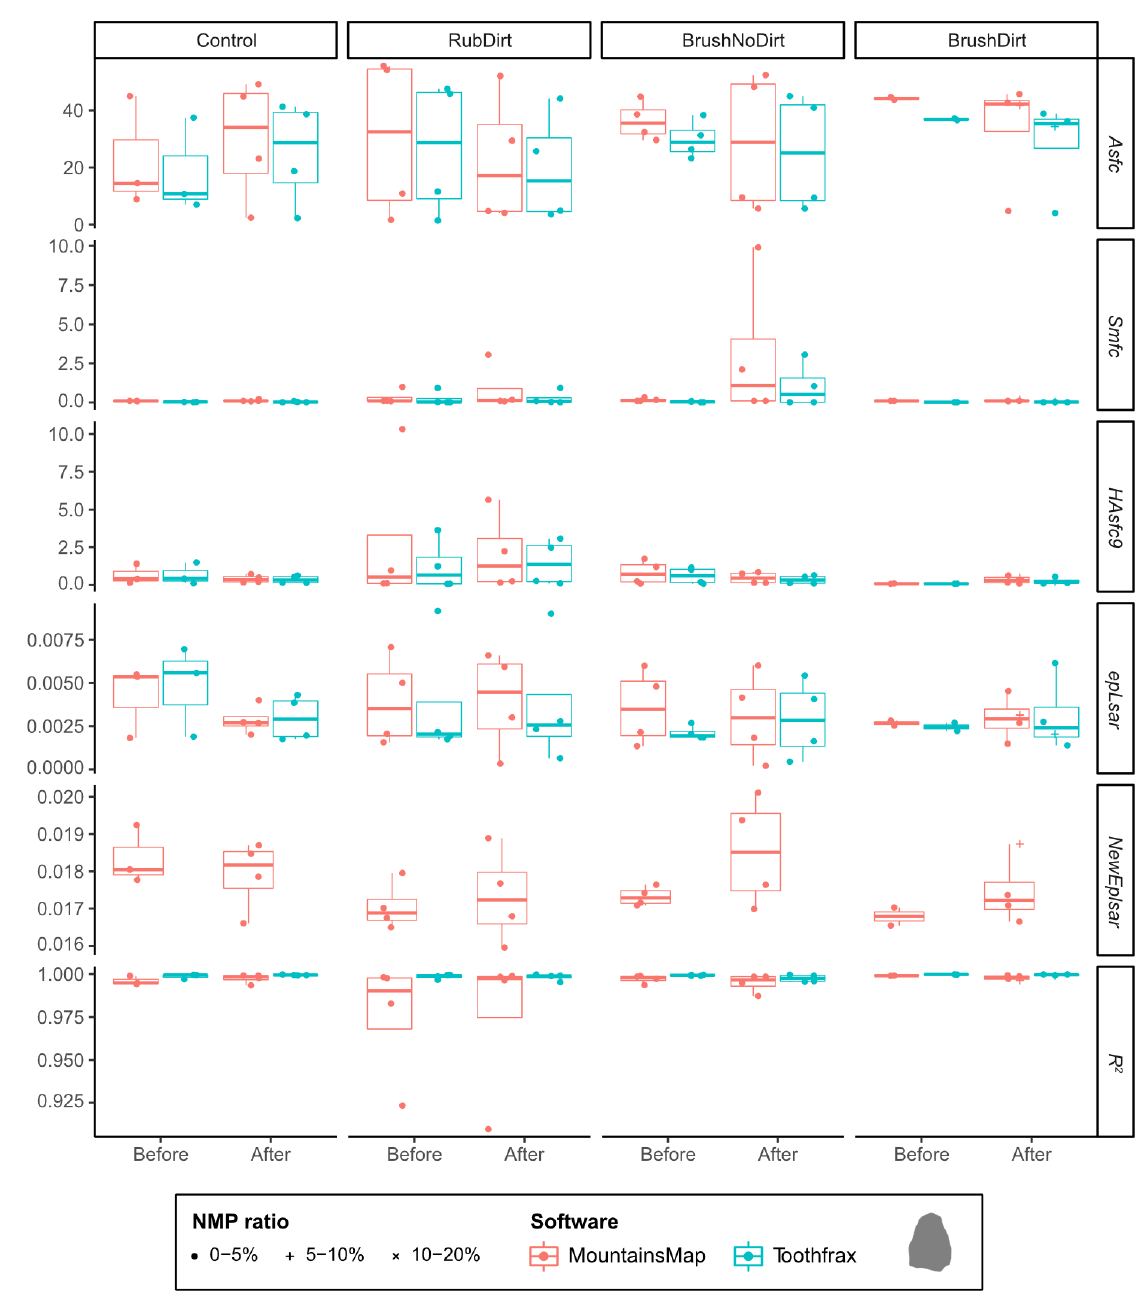
Fig. 3. Boxplots of the SSFA parameters for the lithic dataset. Surfaces with more than 20% NMP were excluded (three surfaces per software package; see "R_analysis/summary_stats/ SSFA_summary- stats.xlsx " on Zenodo). See Fig. 1 for details on boxplots and abbreviations. See text for details on surface parameters and treatments. Silhouette: courtesy from J.